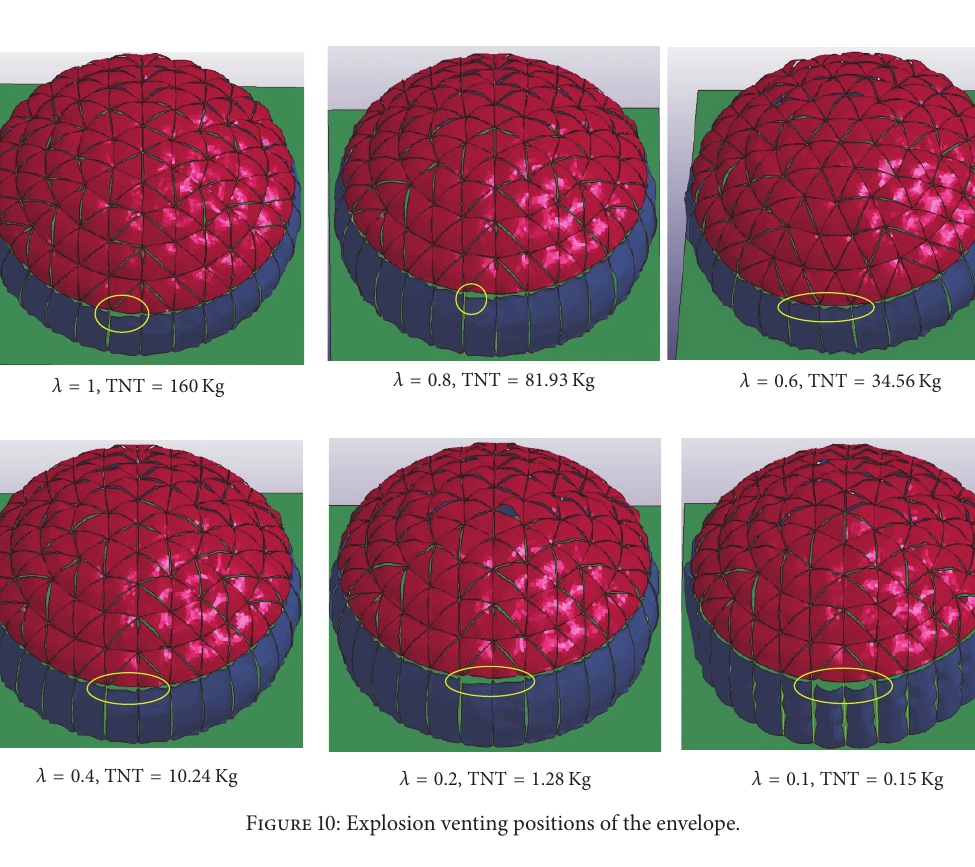
Figure 10: Explosion venting positions of the envelope.